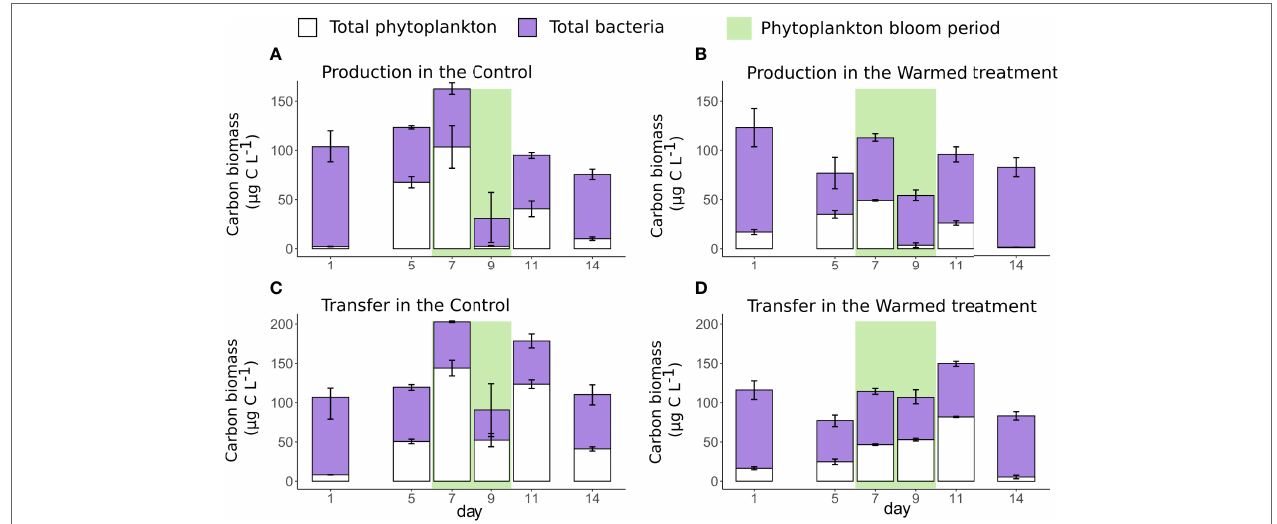
highlights the period of phytoplankton